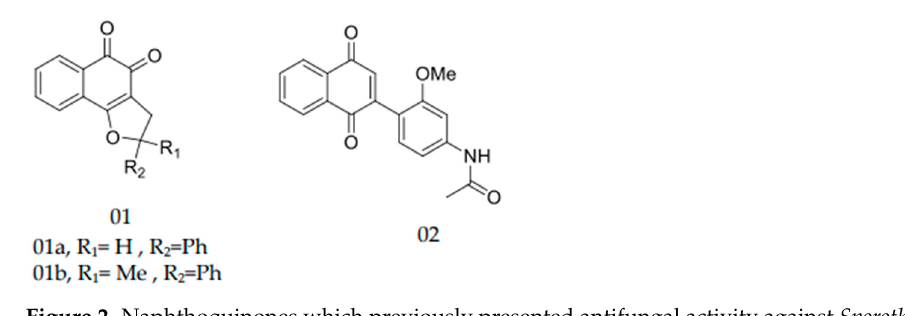
Figure 2. Naphthoquinones which previously presented antifungal activity against Sporothrix spp. as published by Janeczko et al. [31].